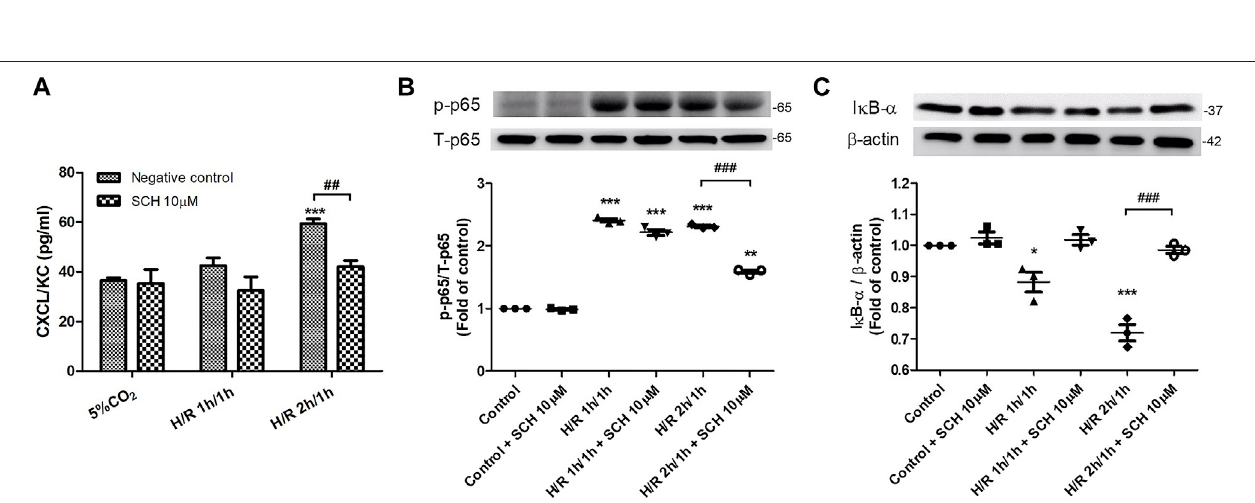
FIGURE 10 | SCH530348 attenuated HR-induced chemokine production and NF- κ B signaling activation in MLE-12 cells. Mouse lung epithelial cells were subjected to HR for 3 h and were treated with vehicle or 10 µM SCH530348. (A) HR-induced MLE-12 cells produced higher CXCL1/KC levels than control group cells, and SCH530348 signi fi cantly decreased chemokine production following HR for 3 h (B,C) SCH530348 signi fi cantly reduced HR-induced NF- κ B p65 phosphorylation and I κ B- α degradation. β -actin was used as an internal control. The data are expressed as the mean ± SD ( n (cid:1) 3 per group). * p < 0.05, ** p < 0.01, *** p < 0.001 compared with the control group; ## p < 0.01, ### p < 0.001, compared with the HR